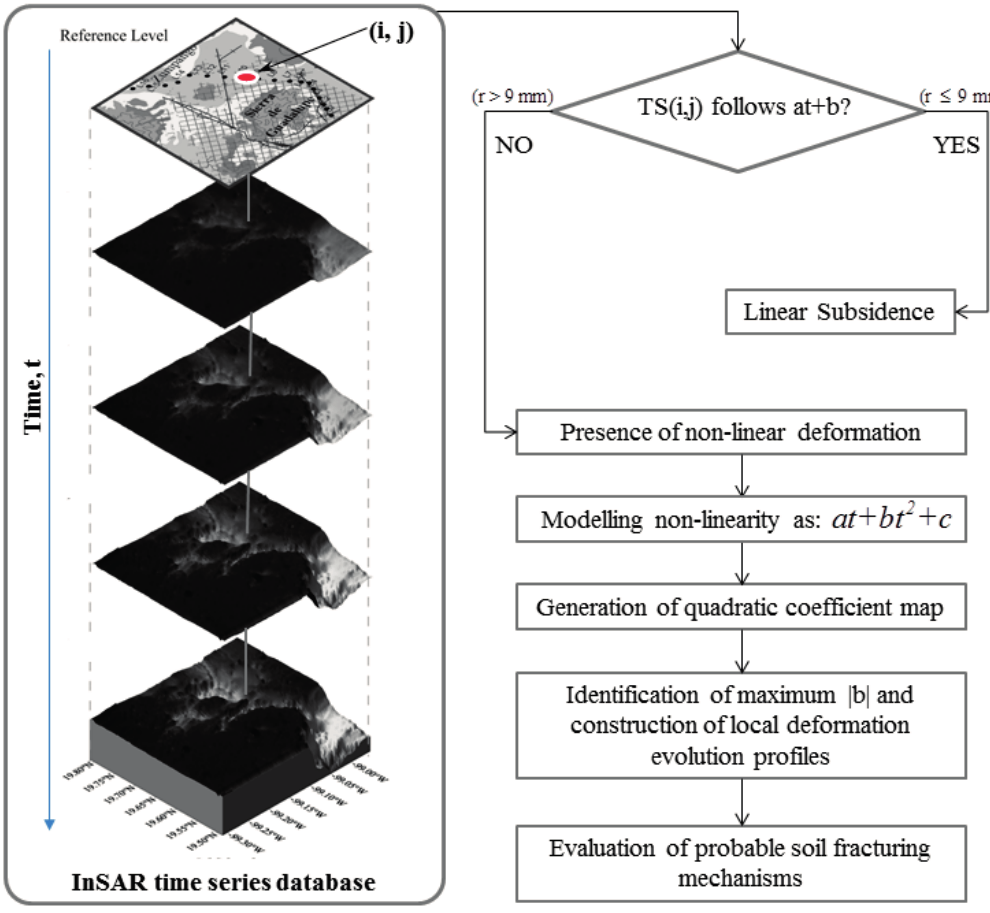
Figure 8. Simplified flowchart of the methodology for soil fracturing